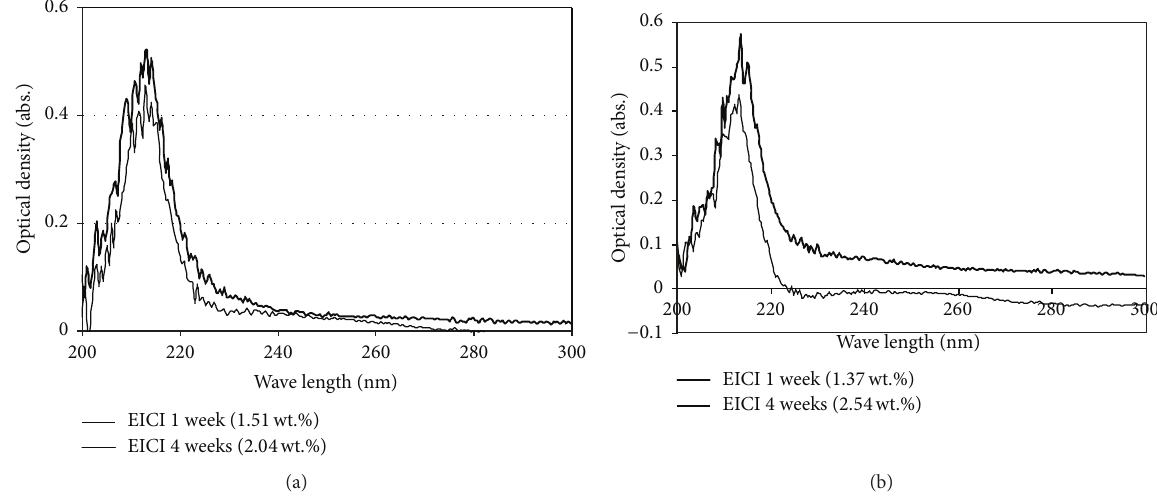
Figure 5: UV-Vis spectra of cement mortar samples after EICI treatment in sodium hydroxide solution: (a) uncontaminated sample; (b) contaminated sample.